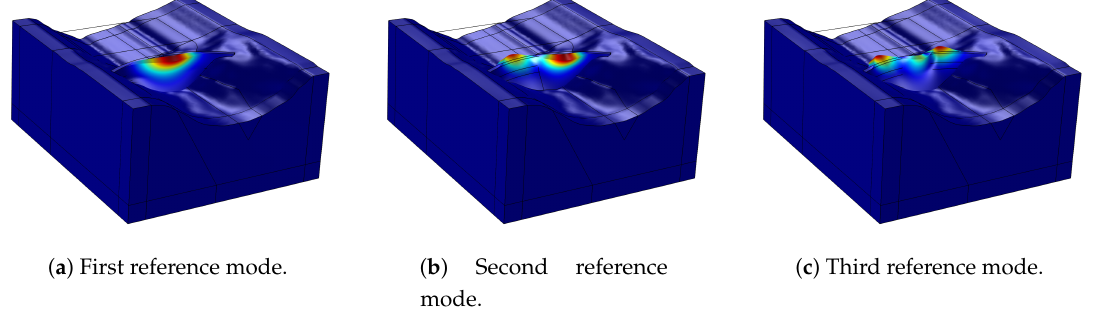
Figure 6. Reference modes for sensitivity analysis.